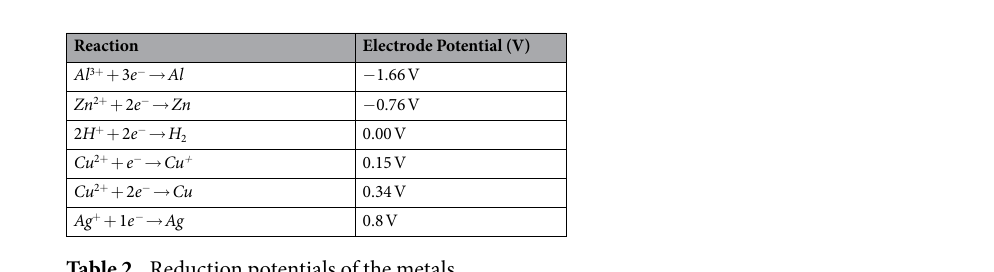
Table 2. Reduction potentials of the